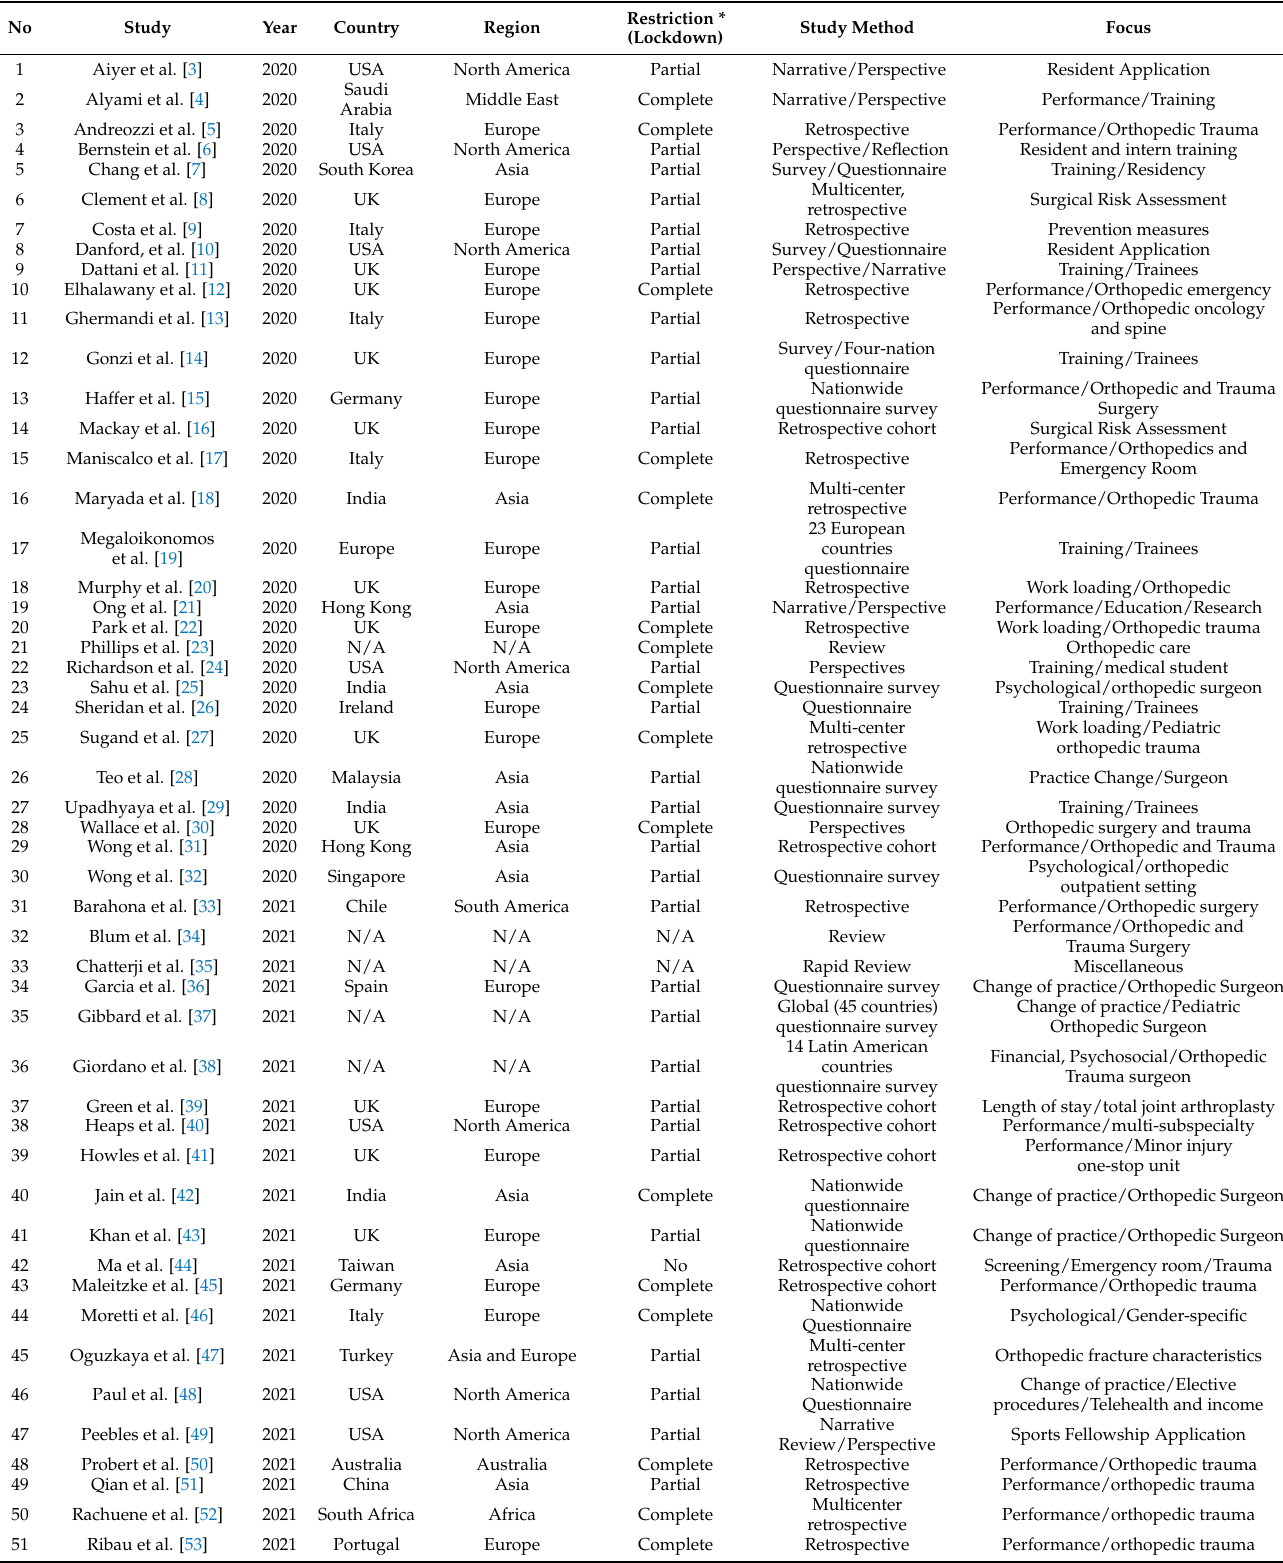
Table 1. Characteristics of relevant